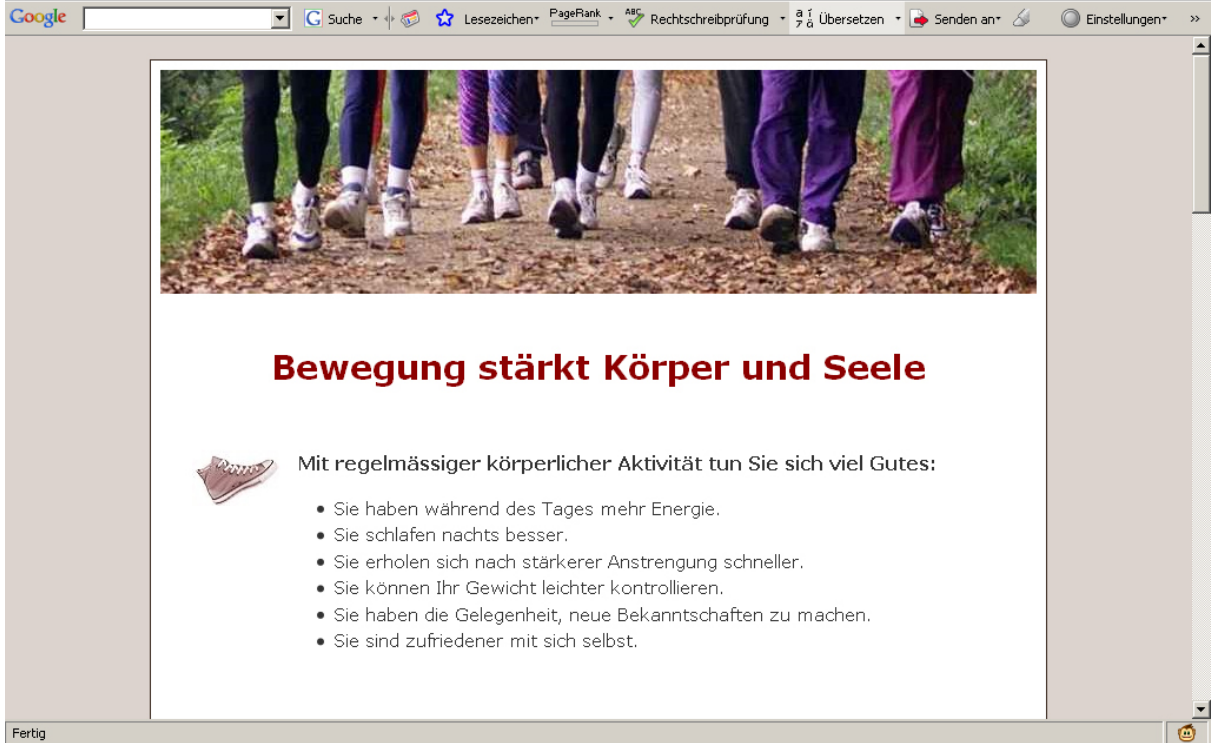
Figure 3. Screenshot of the standard website for the